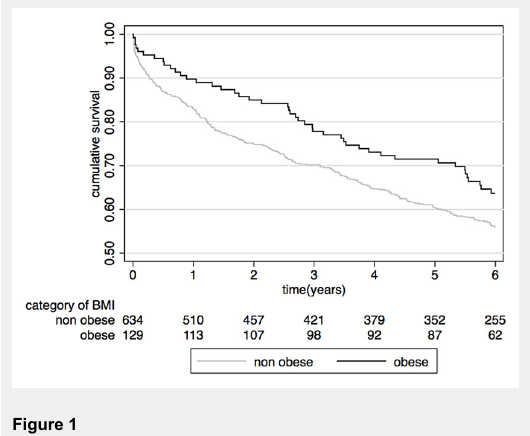
Association between obesity and survival in a cohort of patients with community-acquired pneumonia. nonobese = body mass index (BMI) <30 kg/m 2 ; obese = BMI ≥30 kg/m 2 Possible explanations of the obesity